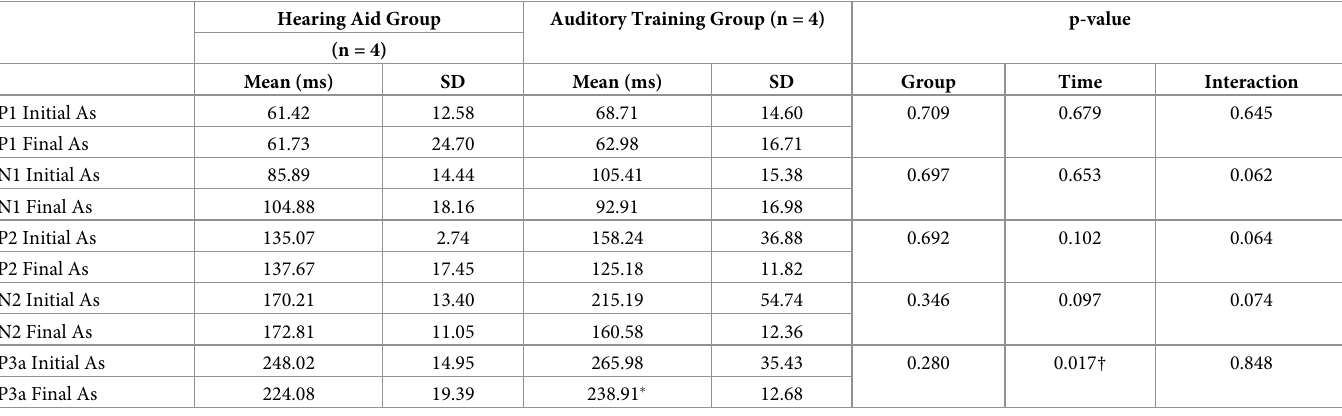
Table 4. Mean and standard deviation of the cortical auditory evoked potential latency values (ms) at the two assessed moments. Hearing Aid